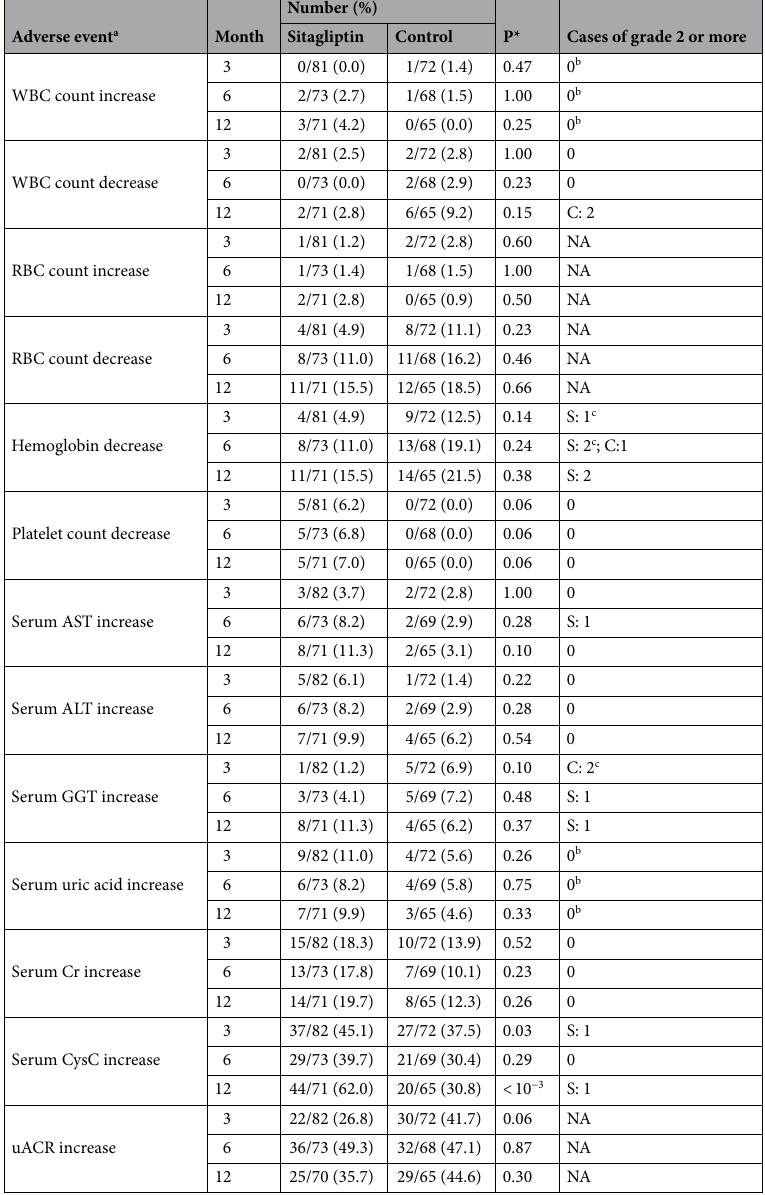
Table 5. Laboratory adverse effects by follow-up point. *Between-group differences were based on Fisher’s exact test. a Defined in accordance with the Common Terminology Criteria for Adverse Events (CTCAE) version 5. Adverse effects were not defined for RBC count or serum CysC levels in the CTCAE. An increase in serum CysC level was defined by applying the criteria used for serum creatinine. An increase (or decrease) in RBC count was defined when the value was greater (or less) than the upper (or lower) limit of the normal range and also greater (or less) than the baseline value. b Grade 2 was not defined in the CTCAE, and no grade 3 cases were noted. c Included one case each of grade. AST aspartate aminotransferase, ALT alanine aminotransferase, C control, Cr creatinine, CysC cystatin C, GGT gamma-glutamyl transferase, NA not applicable, RBC red blood cell, S sitagliptin, uACR urinary albumin-creatinine ratio, WBC white blood